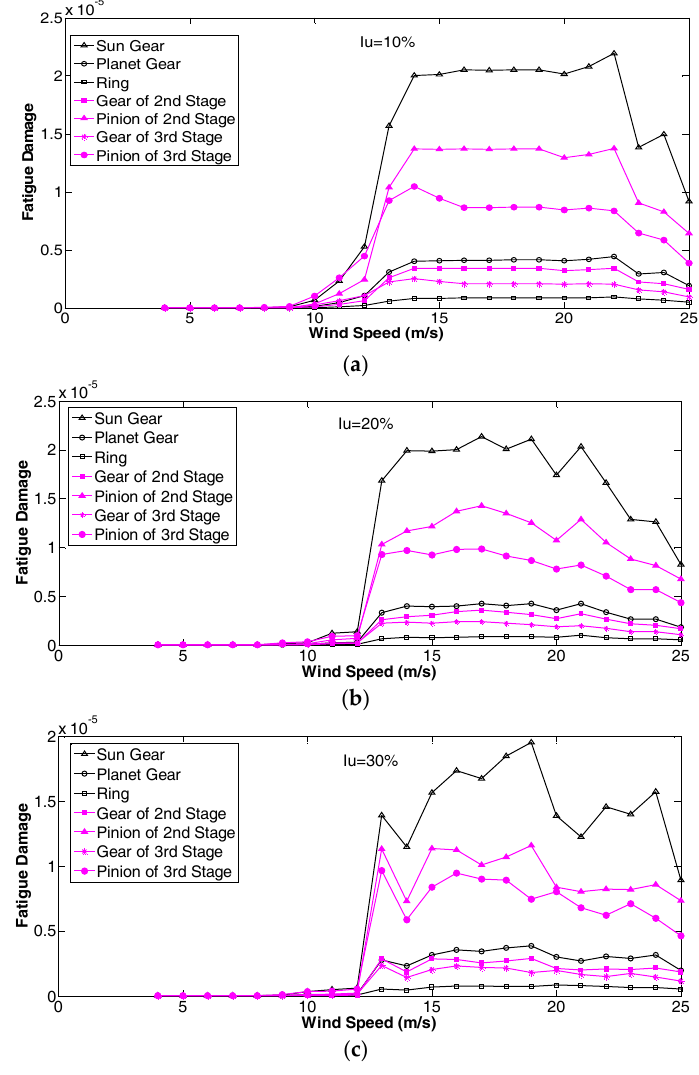
Figure 13. Fatigue damage of different gears under different mean wind speeds and the same turbulence scale: ( a ) Iu = 10%; ( b ) Iu = 20%; and ( c ) Iu = 30%.